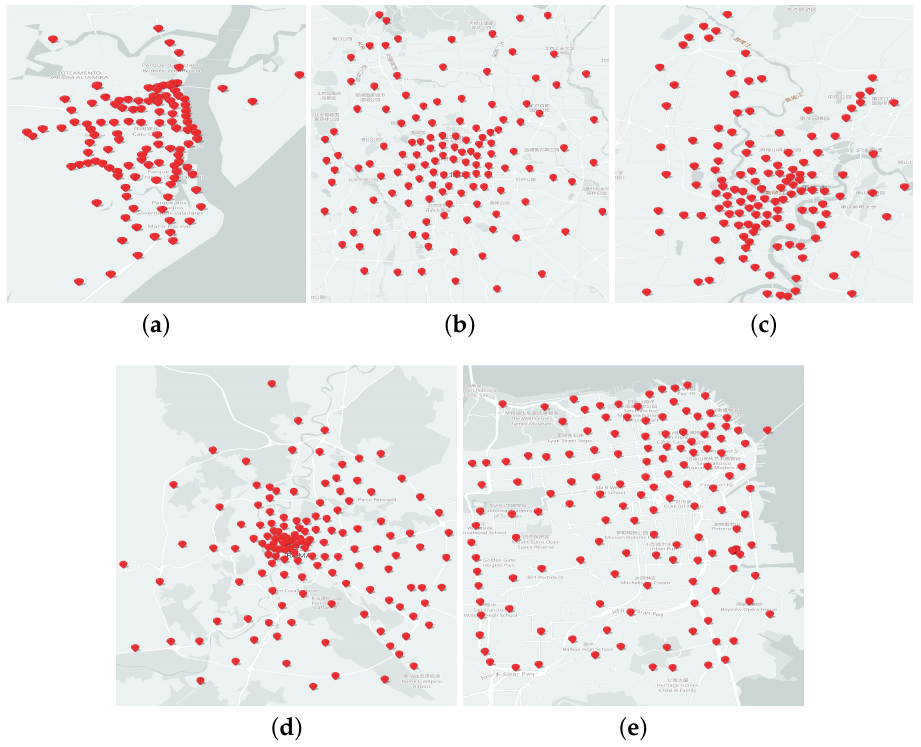
Figure 17. The urban hotspots captured by the PSOCK algorithm. ( a ) Aracaju; ( b ) Beijing; ( c ) Chongqing; ( d ) Roma; ( e ) San